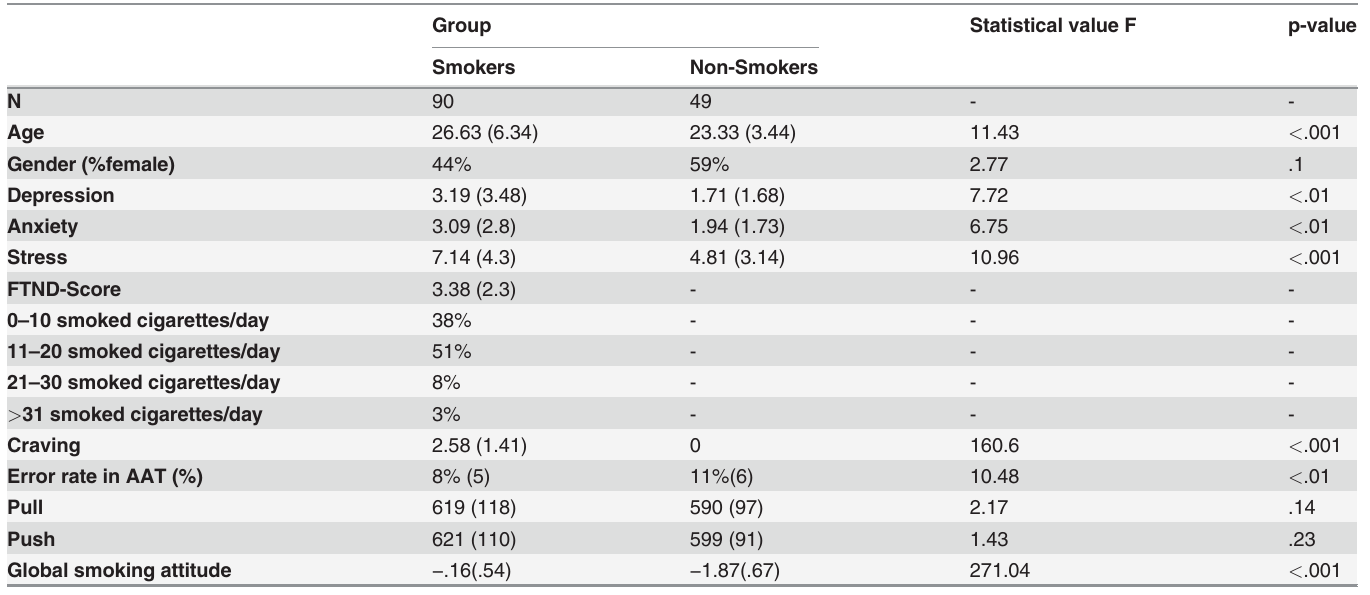
Table 1. Mean sample characteristics and performance in the